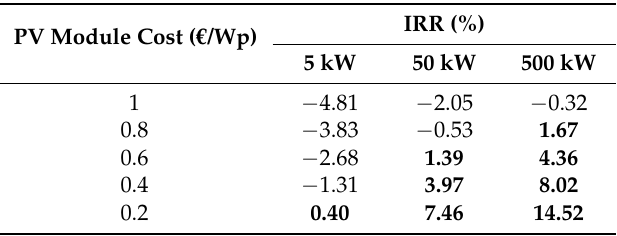
Table 16. Comparison of the IRR based on the Monte Carlo method for all the cases.